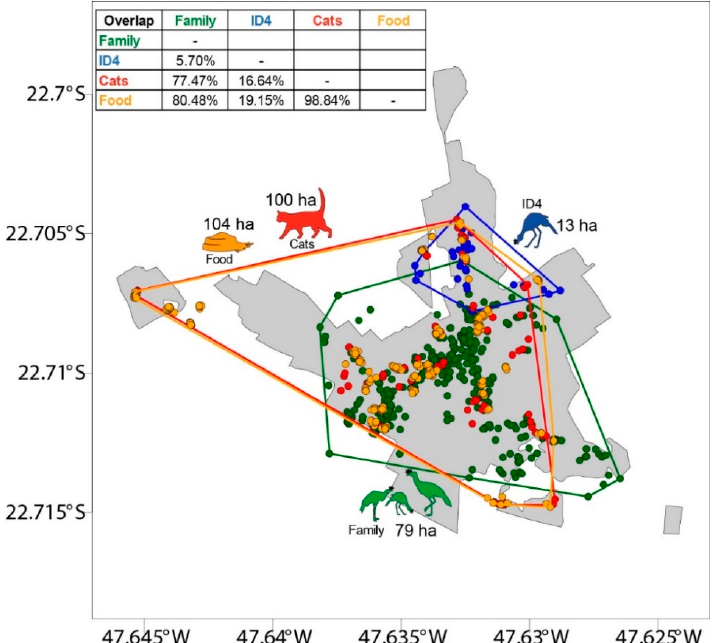
Figure 2. Polygons of distribution based on the convex hull approach showing the home-range size and spatial overlap between: Red-legged Seriema family (green), Seriema individual “ID4” (blue), free-ranging cats (red), and cat-feeding points (orange), within the urbanized area of the “Luiz de Queiroz” campus. Citizen’s records were used to estimate the home range of the Seriemas. Animals 2019 , 9 , x